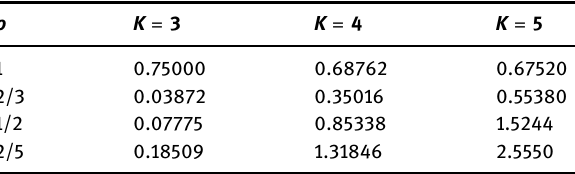
Table 6: The error for di ff erent values of ρ and for di ff erent number of non zero terms ( K ) in the series solution by the D ( TQ ) M ( at t = 0.5, M = N = 15 ) in Example 4.2